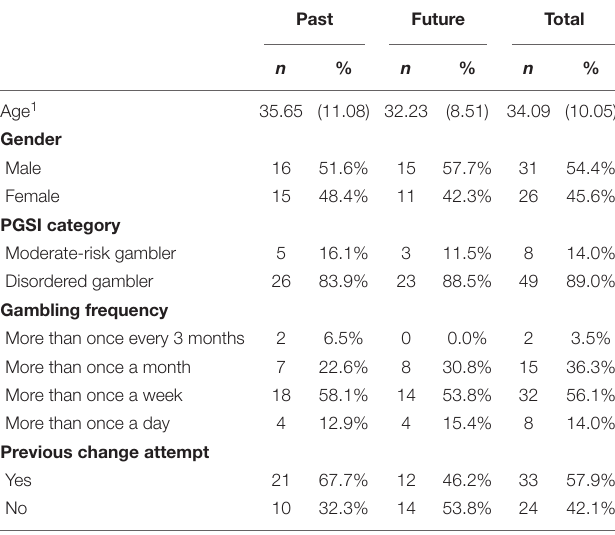
TABLE 1 | Demographics among participants in each condition.